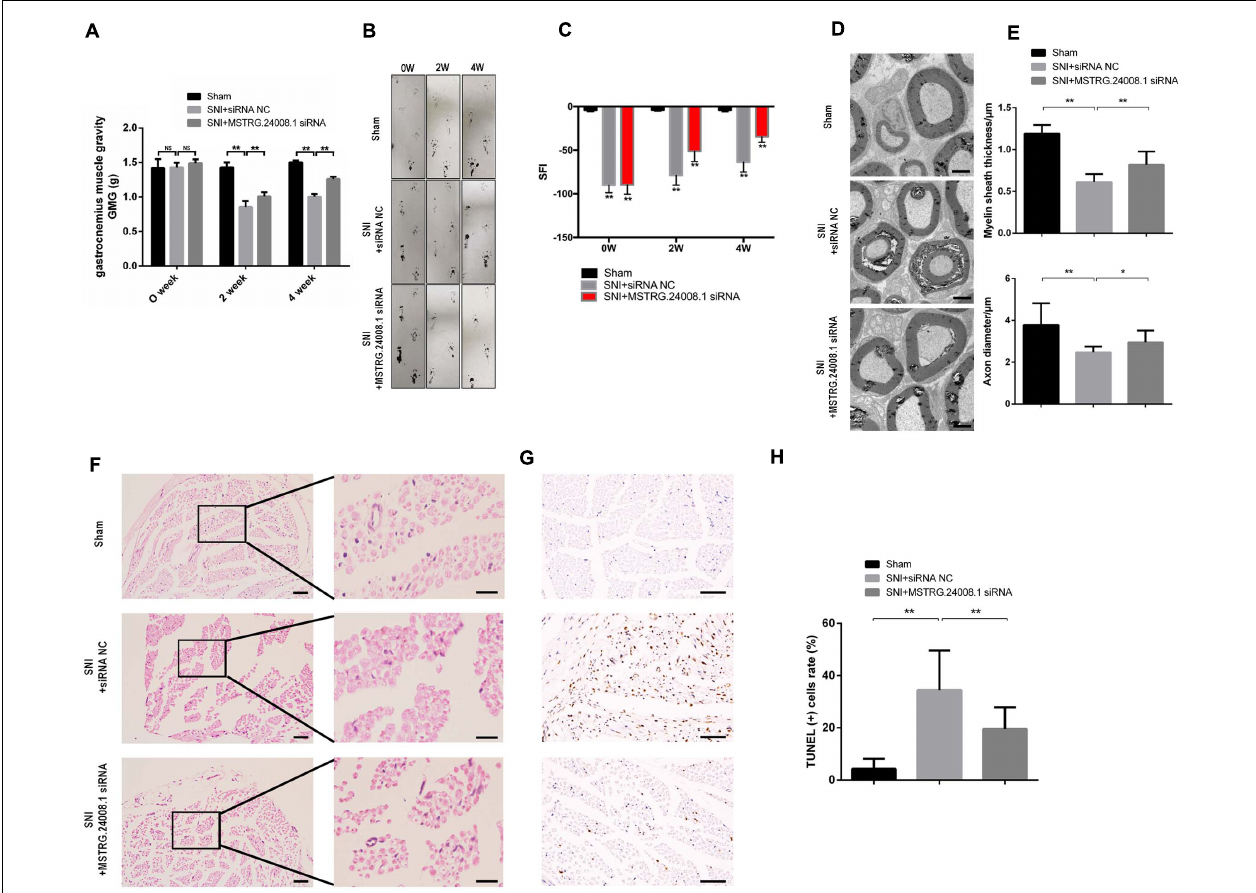
FIGURE 5 | MSTRG.24008.1 regulates the regeneration of SNI in vivo . (A) GMG in the SNI + MSTRG.24008.1 siRNA group increased significantly. Student’s t -test, ** P < 0.01. Data are represented as the means ± SD. (B) Rat footprint function assessment ( n = 6). (C) The SFI from (B) were measured using statistical analysis. Student’s t -test, ** P < 0.01. Data are represented the means ± SD. (D) TEM showing that the myelin sheath thickness and axon diameter of SNI increased after MSTRG.24008.1 siRNA treatment ( n = 6). (E) The myelin sheath thickness and axon diameter in (D) measured using Image-Pro Plus 6.0 software. Student’s t -test, * P < 0.05, ** P < 0.01. Data are represented as the means ± SD. (F) Sciatic nerves analyzed using H&E staining. (G) Sciatic nerves analyzed using TUNEL staining. (H) The number of apoptotic cells in (G) were counted. Student’s t -test, * P < 0.05, ** P < 0.01. Data are represented as the means ± SD. Scale bar: 5 µ m in (D) , 50 and 10 µ m in (F) , and 20 µ m in (G) . Data are representative of at least three independent